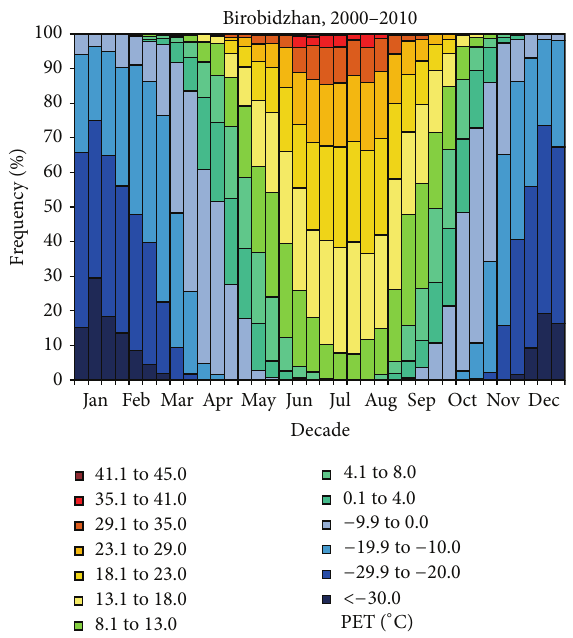
Figure 6: Mean frequency distribution of PET values in Biro- bidzhan, zone 3, during the year divided into 10-day intervals (decades) for the period